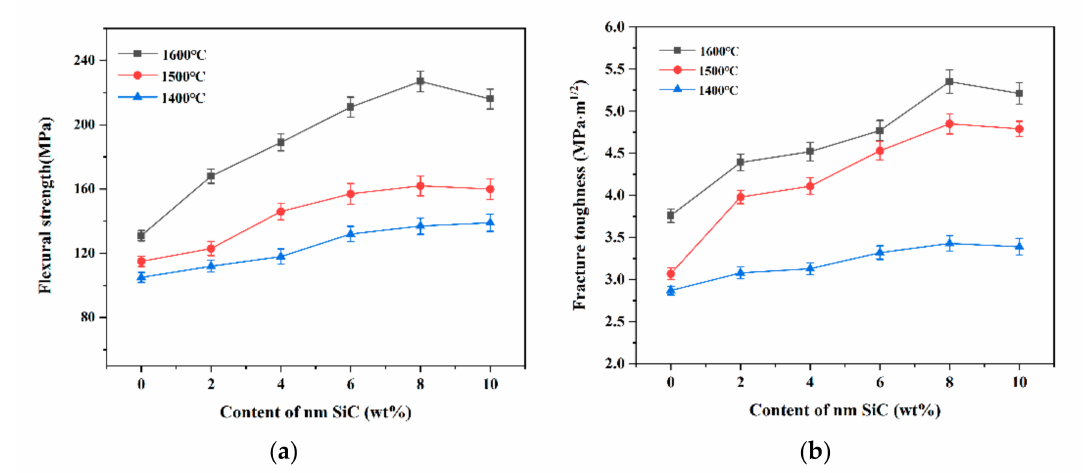
Figure 7. Mechanical properties of composite ceramics with different contents of silicon carbide at different temperatures. ( a ) flexural strength; ( b ) fracture toughness.